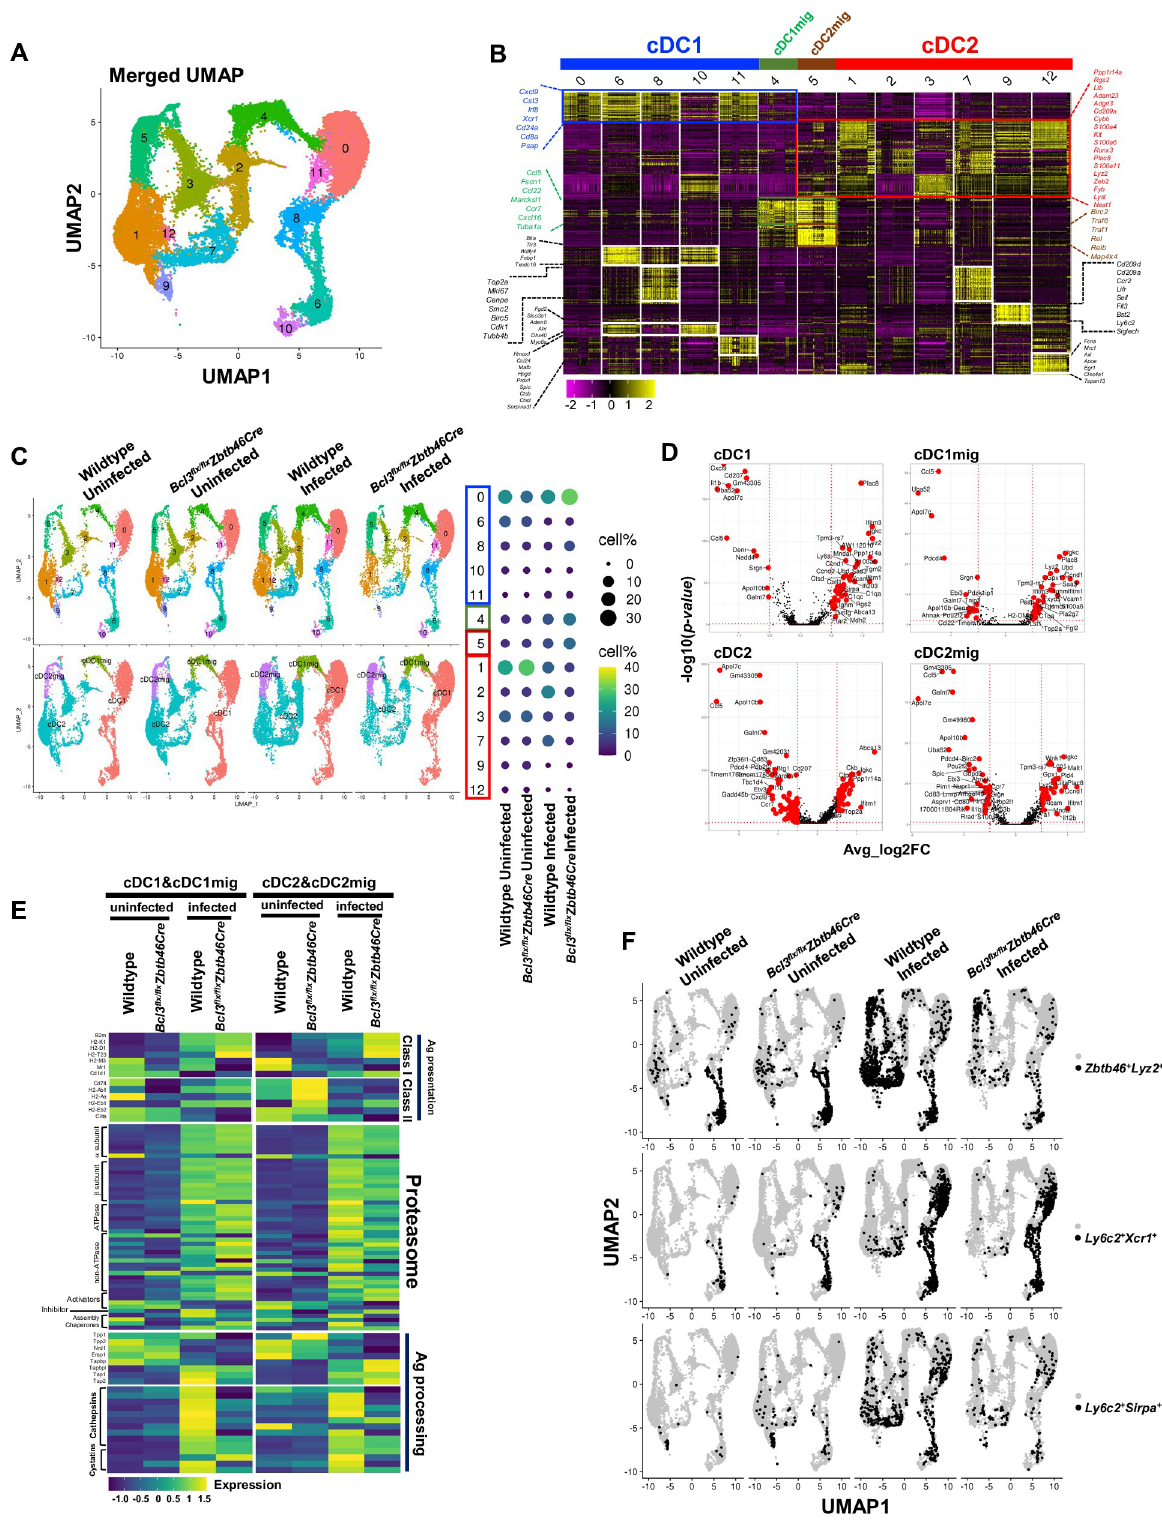
Fig 3. Classical dendritic cell Bcl3 deficiency distorts the distribution of dendritic cell subsets after T . gondii infection. Splenic CD11c + cells were enriched by magnet-based sorting from uninfected wildtype and Bcl3 flx/flx Zbtb46 cre mice, as well as from wildtype and Bcl3 flx/flx Zbtb46